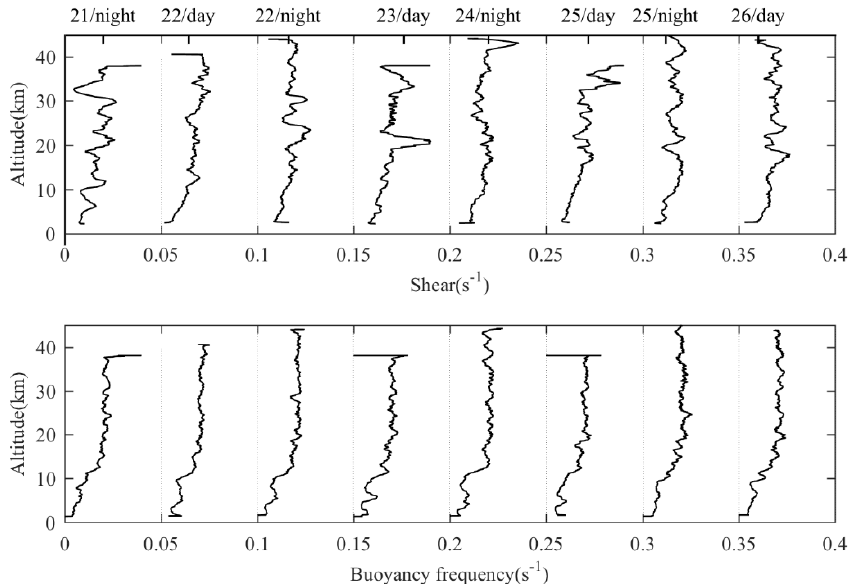
Figure 1. Vertical wind shear (s − 1 ) (top panel), buoyancy frequency (s − 1 ) (bottom panel) from eight soundings. Successive profiles are displaced by 0.05 s − 1 for wind shear and buoyancy frequency.